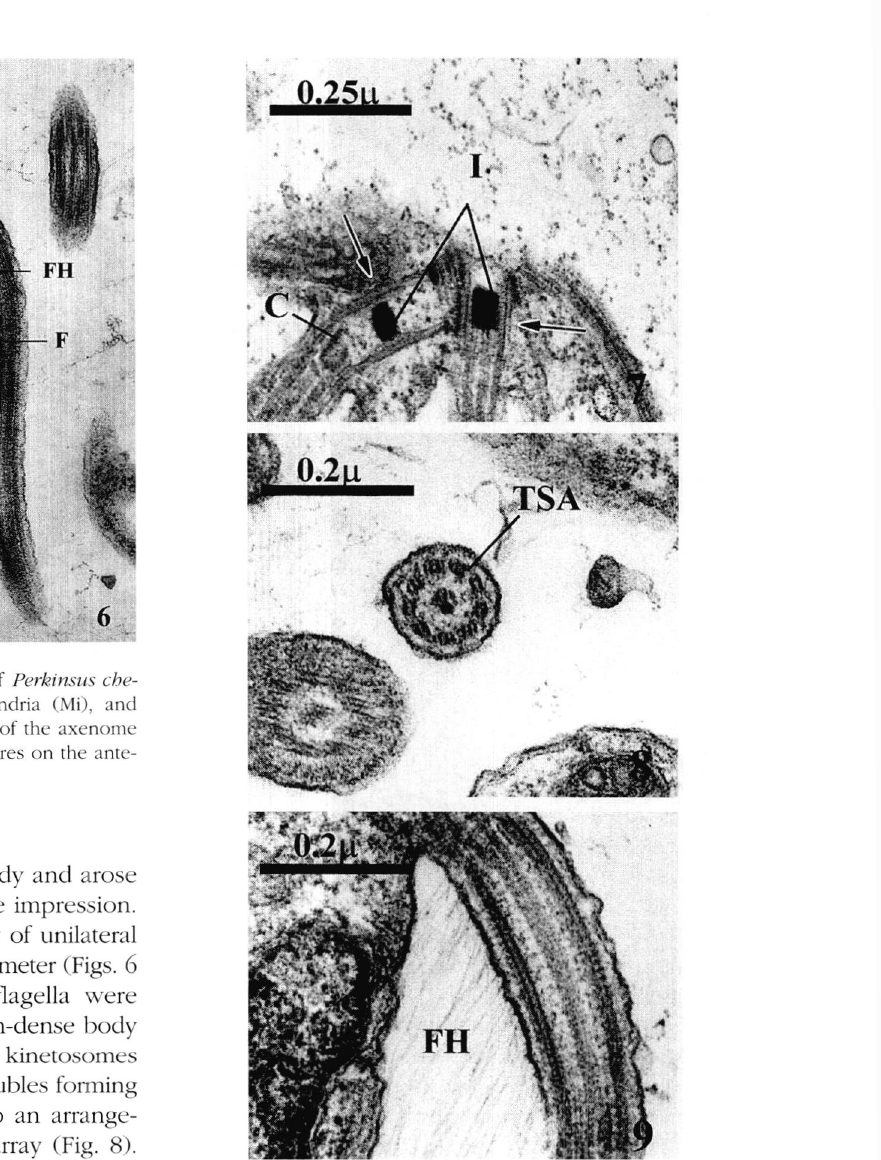
Figs 7-9. - L'ltrastructural details of the flagella in a free zoospore of Perkinsus chesapeaki sp. nov. 7: Kinetosome of both flagella (arrows) showing a cylindrical inclusion (I) and a cup-like structure (C). 8: Transverse section of axoneme (TSA) showing typical micro- tubular arrangement (9 + 2 array). 9: Hair-like structures (FH) located unilaterally along the anterior